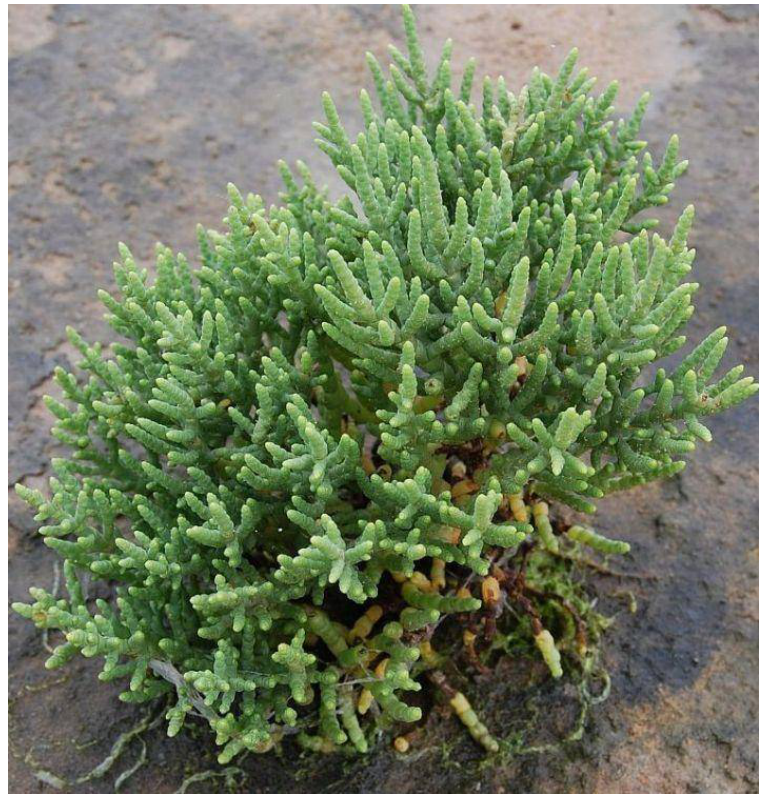
Figure 2. Photograph of Salicornia brachiata in its natural habitat (Gujarat, India).